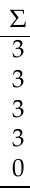
Figure 19. [ SC 1 ] on Figure